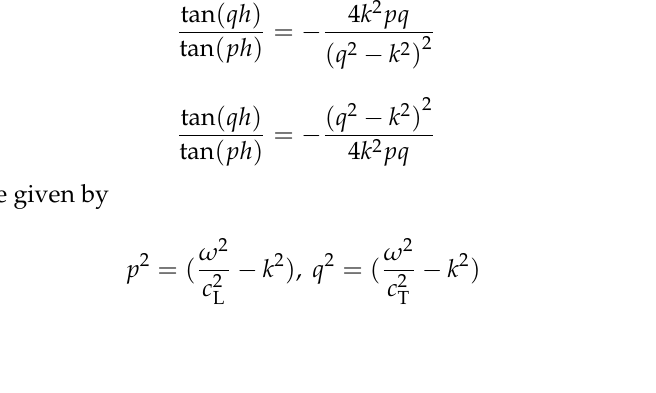
where Γ is the shear-lag coefficient, and the expression is shown in Equation (4). When α = 1, shear excitation is used to excite S mode. When α = 3, bending excitation is used to excite A mode.